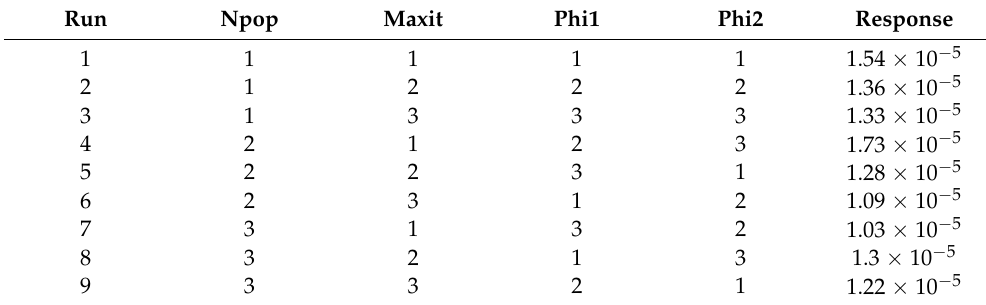
Table A7. The orthogonal array L9 and computational results for MOPSO.